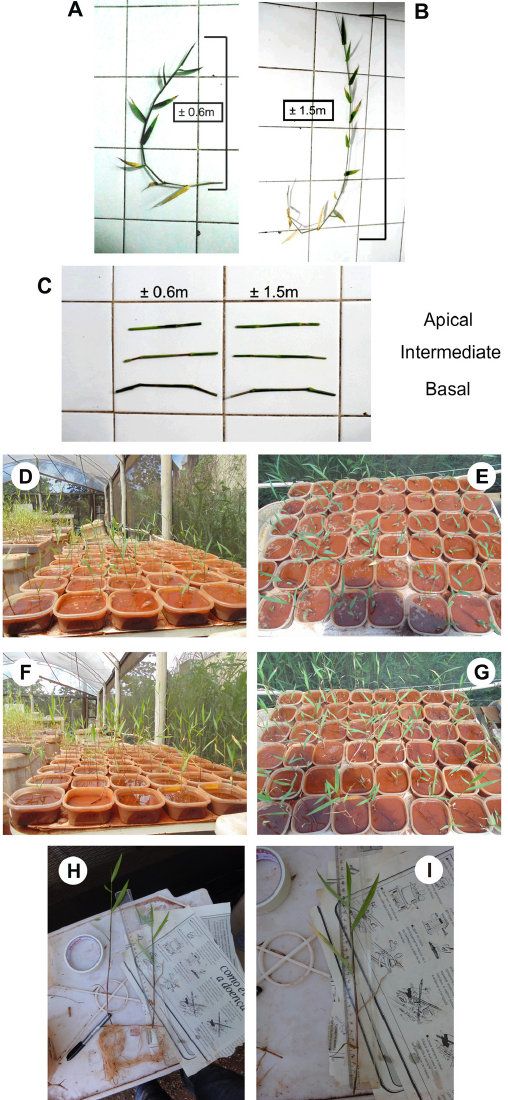
Figure 1. Pictures of parental size and propagules’ positions of U. arrecta ( A , B and C ). Urochloa arrecta ’s sprouts after 10 days of the experiment beginning ( D and E) and at the end (37 days) of the experiment ( F and G ). New sprouts of Urochloa arrecta generated ( H ) and measurement of the new sprout’s length ( I